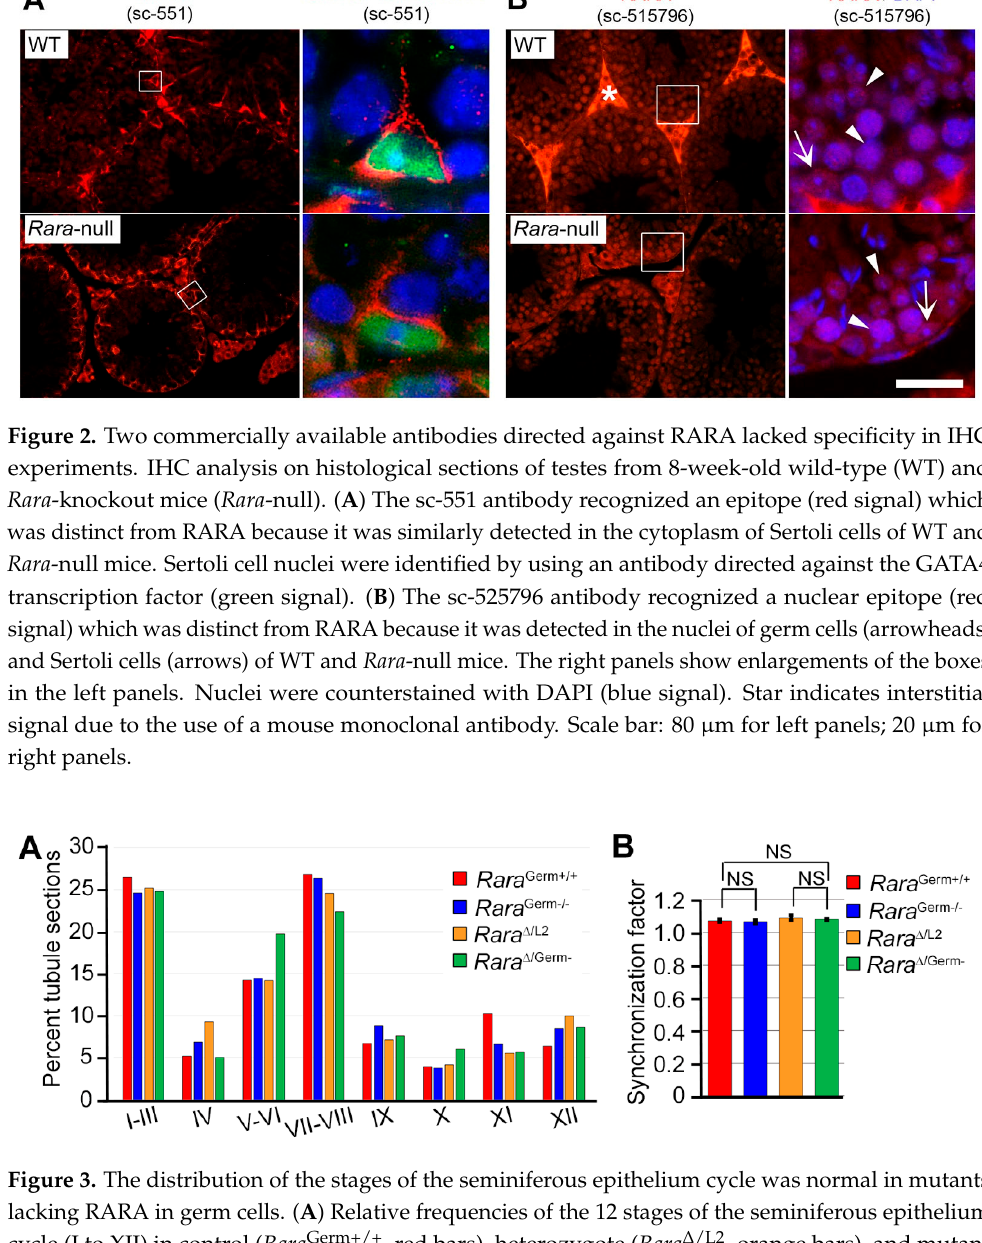
Figure 3. The distribution of the stages of the seminiferous epithelium cycle was normal in mutants lacking RARA in germ cells. ( A ) Relative frequencies of the 12 stages of the seminiferous epithelium cycle (I to XII) in control ( Rara Germ+/+ , red bars), heterozygote ( Rara ∆ /L2 , orange bars), and mutant ( Rara Germ − / − , blue bars; Rara ∆ /Germ − , green bars) mice. ( B ) Calculated synchronization factors. Error bars represent standard deviations (n = 10 for Rara Germ+/+ ; n = 3 for other genotypes). NS, not statistically significant.